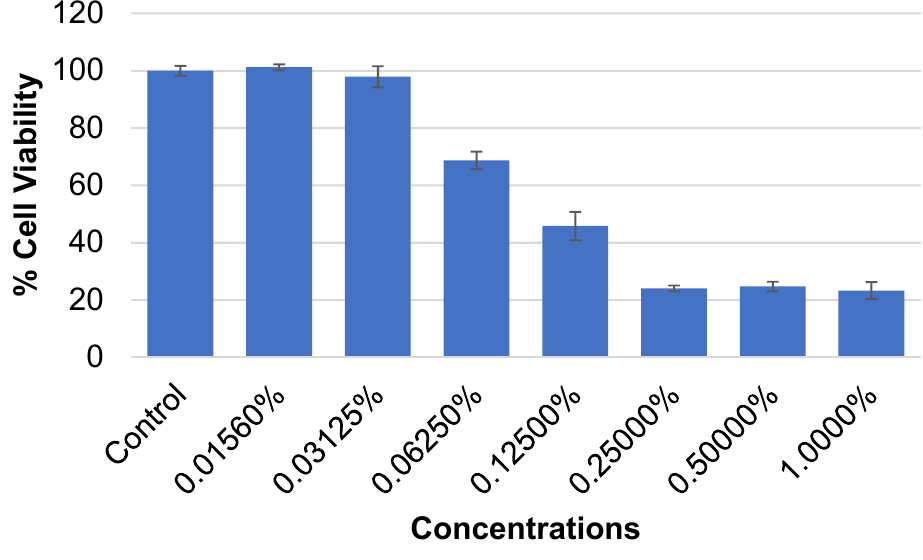
Figure 2. Cytotoxic activity of lavender oil against HEK-293 cells determined by MTT assay. Cells were exposed to different concentrations of the oil for 24 h. All values are presented as mean ± SD.